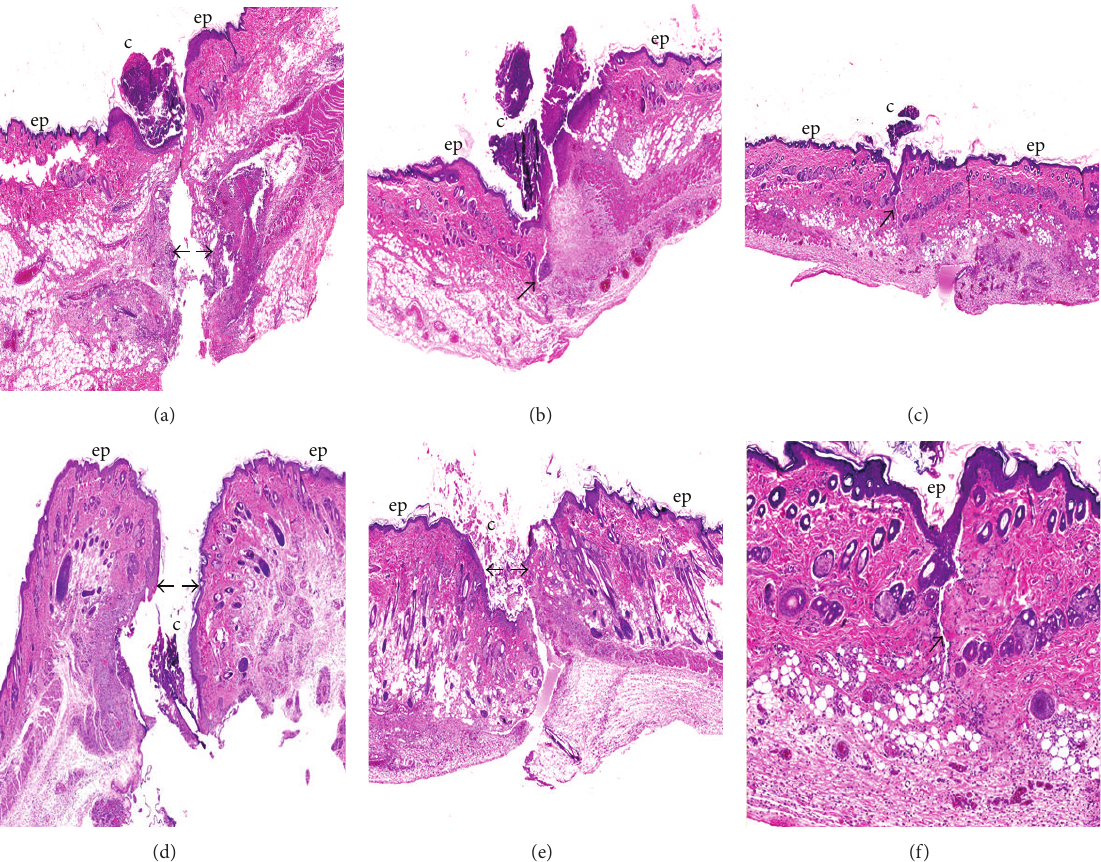
Figure 4: Morphological findings observed in normal rat, nondiabetic ((a), (b), and (c)) and hyperglycemic diabetic ((d), (e), and (f)), untreated or incisions treated with CEC and Zn + TDI, on the 4th postoperative day, respectively. Note the fibrin crust leukocyte (c) and the almost complete contraction of surgical margins (arrows) and reepithelialization of advanced epithelial surface (ep) in diabetic animals treated with Zn + TDI compared to nondiabetic rats treated with incisions or treated with CEC alone (H & E